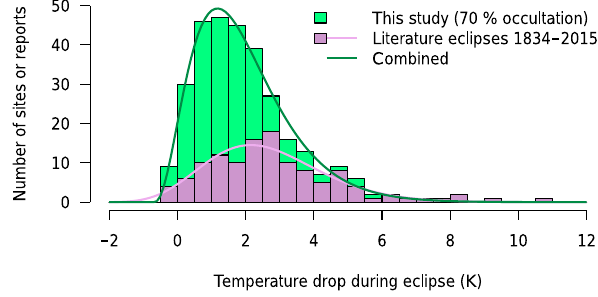
Figure 6. Histogram of temperature reduction at all sites included in this study and those reported in the literature. The stacked bars show number of sites of this study (green bars) on top of those for literature reports (violet bars). The solid lines show the best fit of the scaled probability distributions (Eq. 4, Table 2) of values reported in the literature (violet line) and the combination of literature data with values reported in this study (dark green